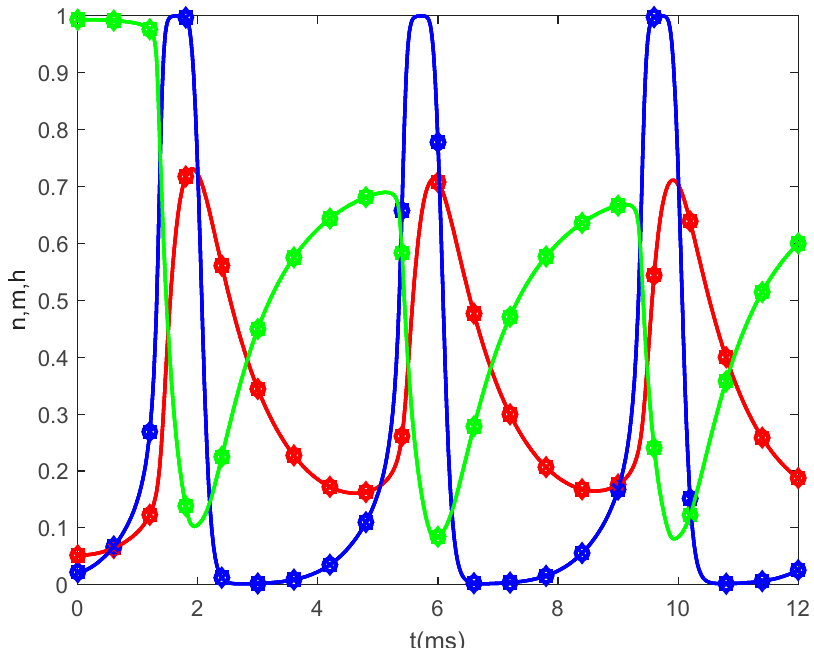
Figure 5. Time variations of the gating variables n ( t ) (red), m ( t ) ( blue), and h ( t ) (green), obtained by solving the fractional Hodgkin–Huxley Equations (35)–(38) for β = 1. Here, p = 1, q = 0, and α = 1 (square symbol); α = 0.65 (diamond symbol); α = 0.5 (circle symbol); and α = 0.25 (x-mark symbol).